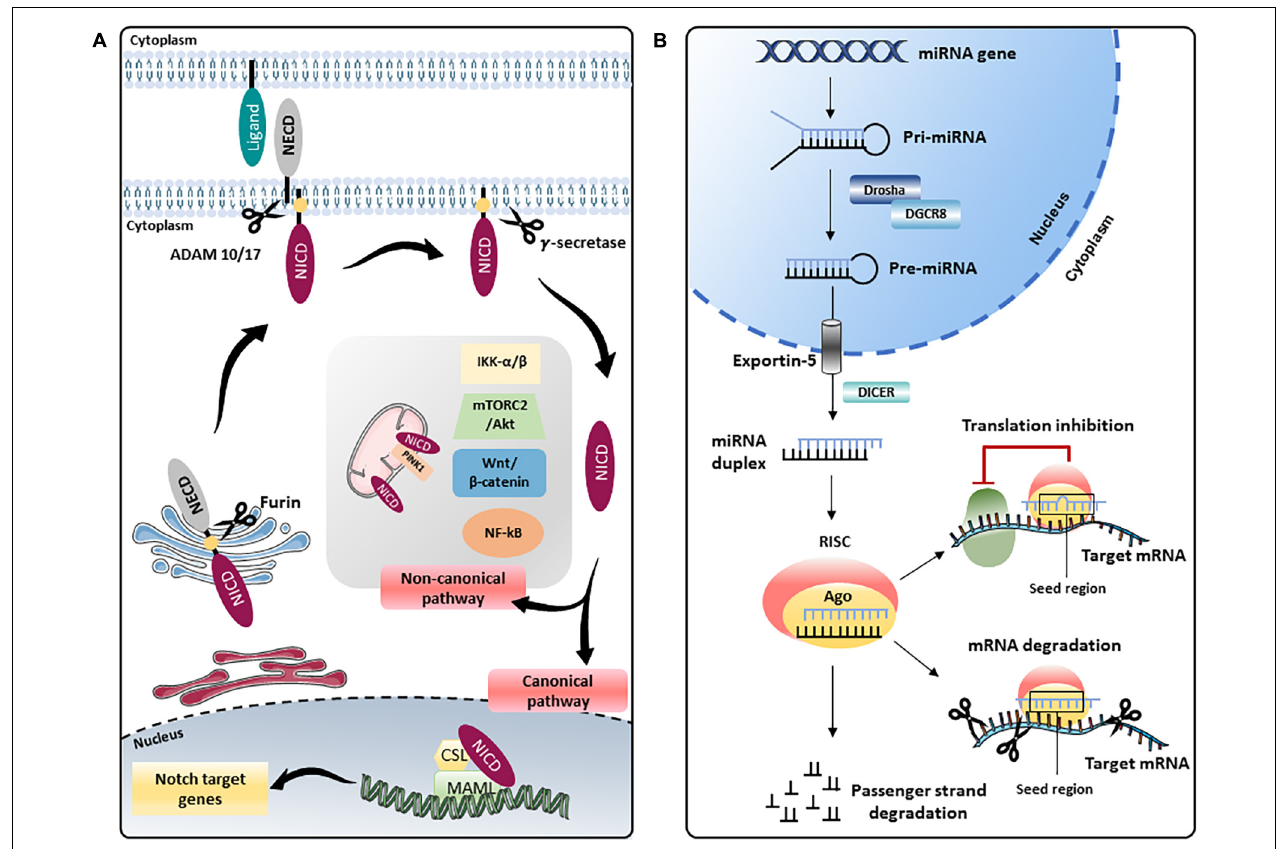
FIGURE 1 | Schematic representation of the Notch pathway and miRNA biogenesis. (A) The Notch precursor is cleaved by a furin-like protease in the Golgi apparatus and then transported to the plasma membrane. Notch receptor on the membrane is activated by the binding with ligands present on adjacent cells, which induces a second proteolytic cut mediated by A Disintegrin And Metalloprotease (ADAM) 10 or 17, followed by a third cleavage by the γ -secretase complex that releases the Notch intracellular domain (NICD). In the “canonical” Notch signaling, NICD translocates into the nucleus and, through the interaction with the transcription factor CBF1/Suppressor of Hairless/LAG1 (CSL) and the Mastermind-like (MAML) adaptor proteins, modulates the transcription of several target genes. In the “non-canonical” signaling, Notch modulates Wnt/ β -catenin, mammalian target of the rapamycin 2 complex (mTORC2)/Akt, Nuclear Factor kappa B (NF- κ B), IkB kinase (IKK)- α / β and phosphatase and tensin homolog (PTEN)-induced kinase (PINK1) on mitochondria, independently from CSL. NECD: Notch extracellular domain. (B) In the nucleus, genes coding for miRNAs are transcribed by RNA polymerase II or III into primary miRNAs (pri-miRNAs), which are processed by the complex consisting of RNA-binding protein DGCR8 and type III RNase Drosha, into a stem-loop structure called precursor miRNAs (pre-miRNAs). Afterward, pre-miRNA is transported into the cytoplasm by Exportin-5 complex (Exportin -5 _ Ran-GTP), where pre-miRNA is processed by another type III RNase enzyme Dicer to form the mature miRNA duplex. The two strands of the duplex are loaded into Argonaute (Ago) protein to form the RNA-induced silencing complex (RISC); one strand (also called guide strand) is selected to form the functional RISC complex, the other strand (passenger strand) is released from Ago and degraded (Medley et al., 2021). For most miRNAs, one strand is preferentially loaded into Ago, forming the functional RISC, while the other is released and degraded. However, for some miRNAs, both strands give rise to functional miRNAs that are loaded into the RISC. Functional miRNAs regulate gene expression at post-transcriptional